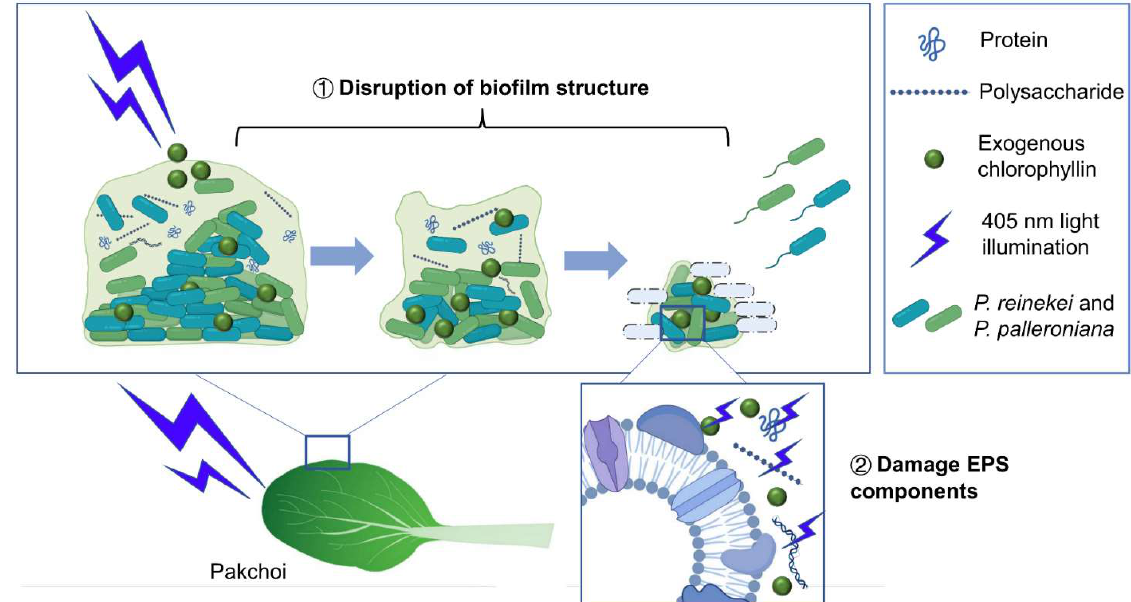
Figure 6. Schematic illustration of biofilm destruction by Chl-based PDI. Chl-based PDI disrupted biofilms by disrupting biofilm structure and subsequent dispersion/reduction in attached microor- ganisms as well as by disrupting extracellular polymeric substance (EPS), including extracellular proteins and polysaccharides.